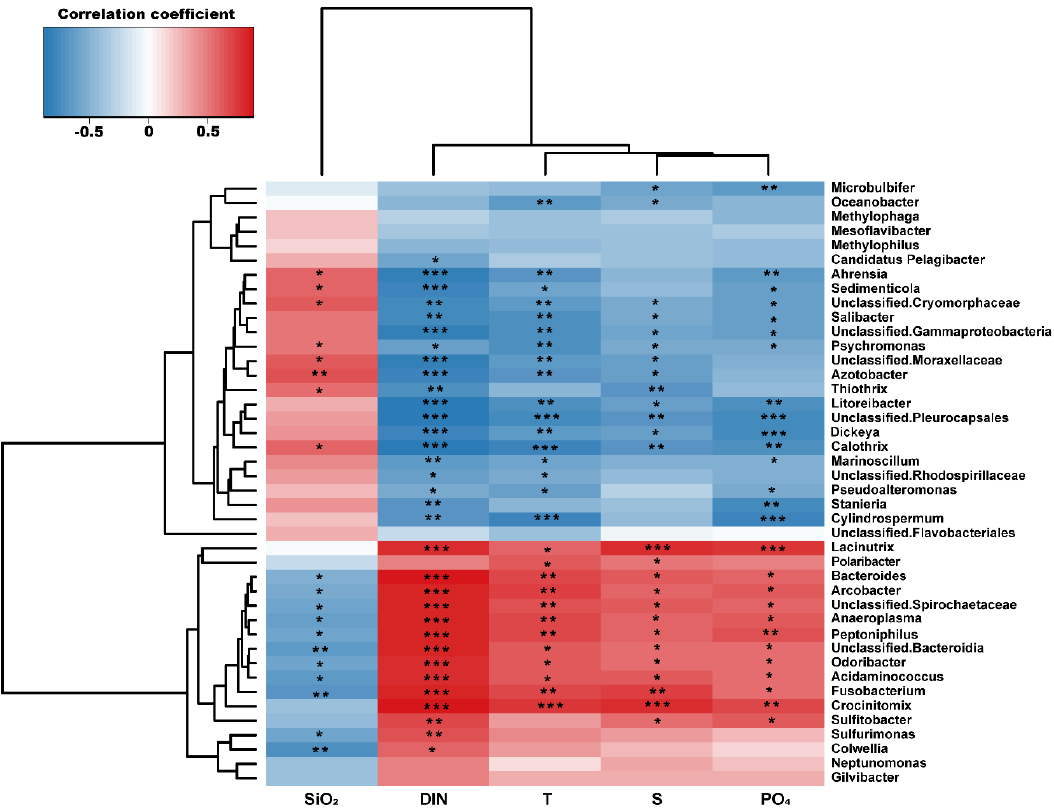
Figure 7. Heatmap from Spearman correlations between environmental parameters (physical: T and S; biogeochemical: DIN, PO 4 , and SiO 2 ) and the bacterial community at the genus level (>1 % in a total sum of relative abundance of all stations). The symbols *, **, and *** indicate a p -value less than 0.05, 0.01, and 0.001, respectively.